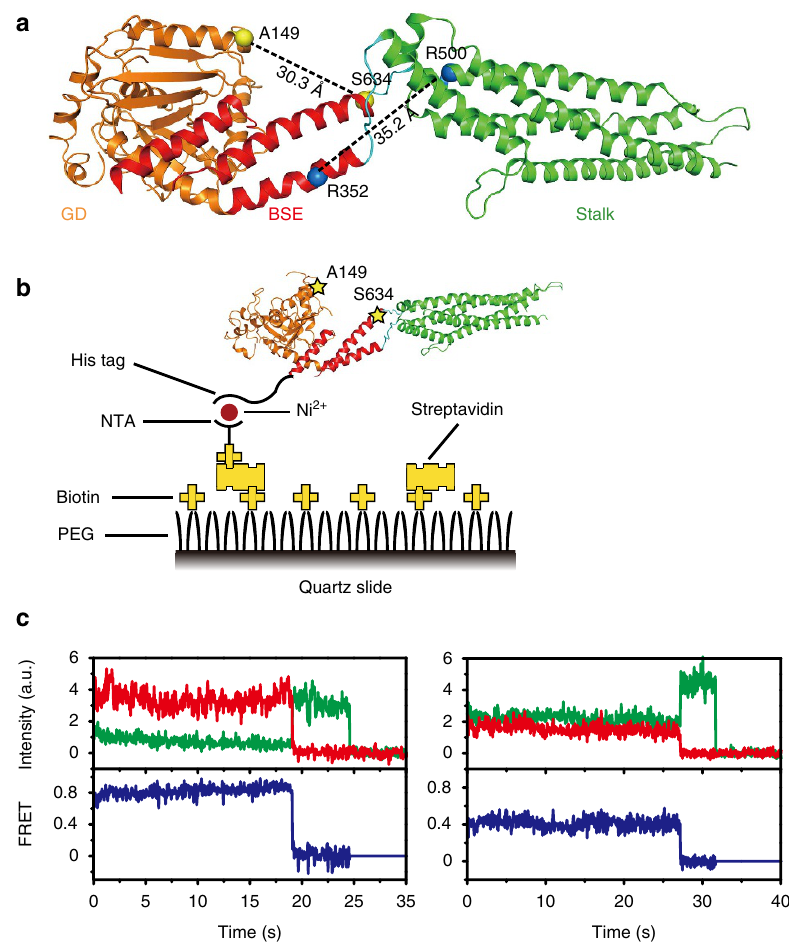
Figure 2 | Strategy of the smFRET assay. ( a ) Selected cysteine (Cys) pairs for dye labelling. Positions of A149C/S634C and R352C/R500C pairs are specified with yellow and blue spheres, respectively. Distances between the C b atoms in each Cys pair are indicated. Domains of MxA MO2 are coloured as in Fig. 1a. ( b ) Immobilization strategy. His 6 -tagged MxA MO2 -AS (shown here as an example for all measured samples) labelled with Cy3 and Cy5 (stars) was immobilized via biotin-NTA-Ni 2 þ on a PEG/biotin-PEG-coated quartz slide treated with streptavidin. ( c ) Representative traces (Cy3 as donor in green, Cy5 as acceptor in red, and FRET in blue) from the assay on MxA MO2 -AS in the nucleotide-free